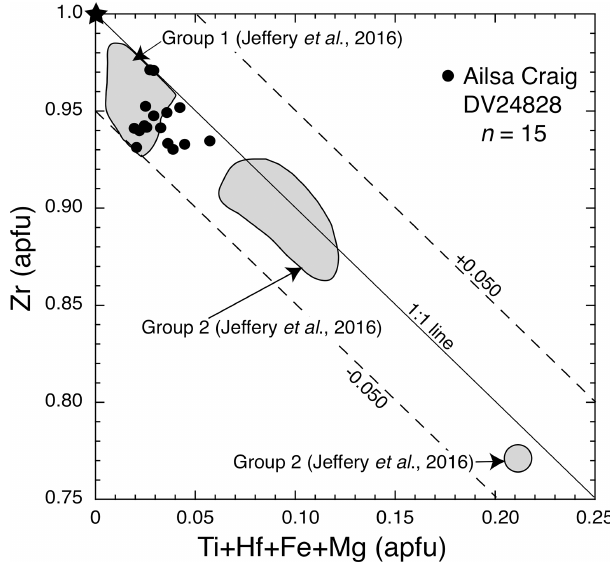
Figure 14. Variation diagram of Zr versus (Ti + Hf + Fe + Mg) apfu, showing substitution in the octahedral site in dalyite from sam- ple DV24828, EPMA data, adapted from Jeffery et al. (2016). Also shown is the ideal dalyite composition (star) and dalyite compositional Group 1 (Terceira, Straumsvola, Ascension, Strange Lake) and Group 2 (Sunnfjord, Cancarix, Murun) from Jeffery et al.